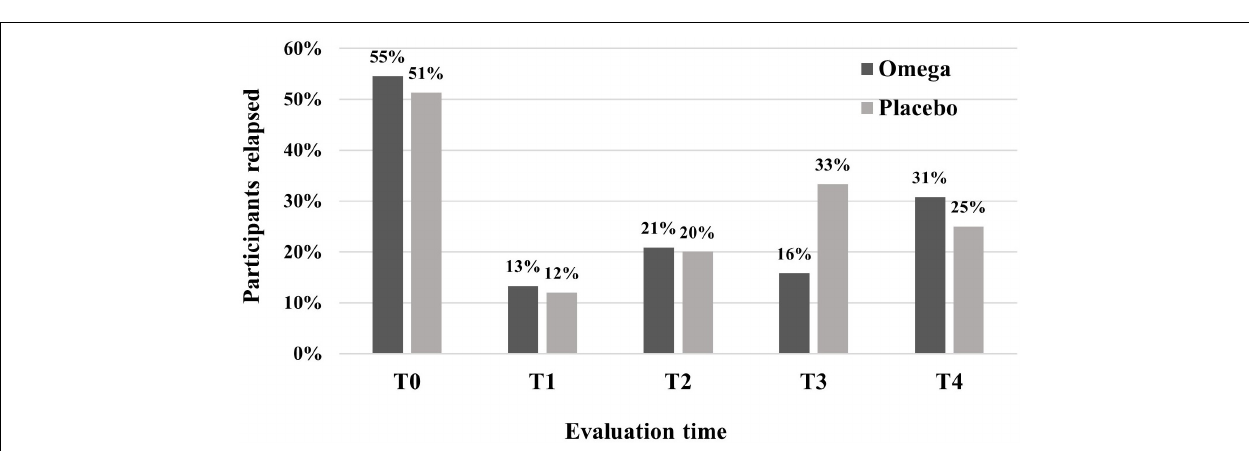
FIGURE 3 | Percentage of participants who had at least one drinking episode (lapse or relapse), as evaluated by the TLFB, in the omega-3 and control groups across time. No significant differences were found between the groups [Wald χ 2 (4) = 1.66, p = 0.80].